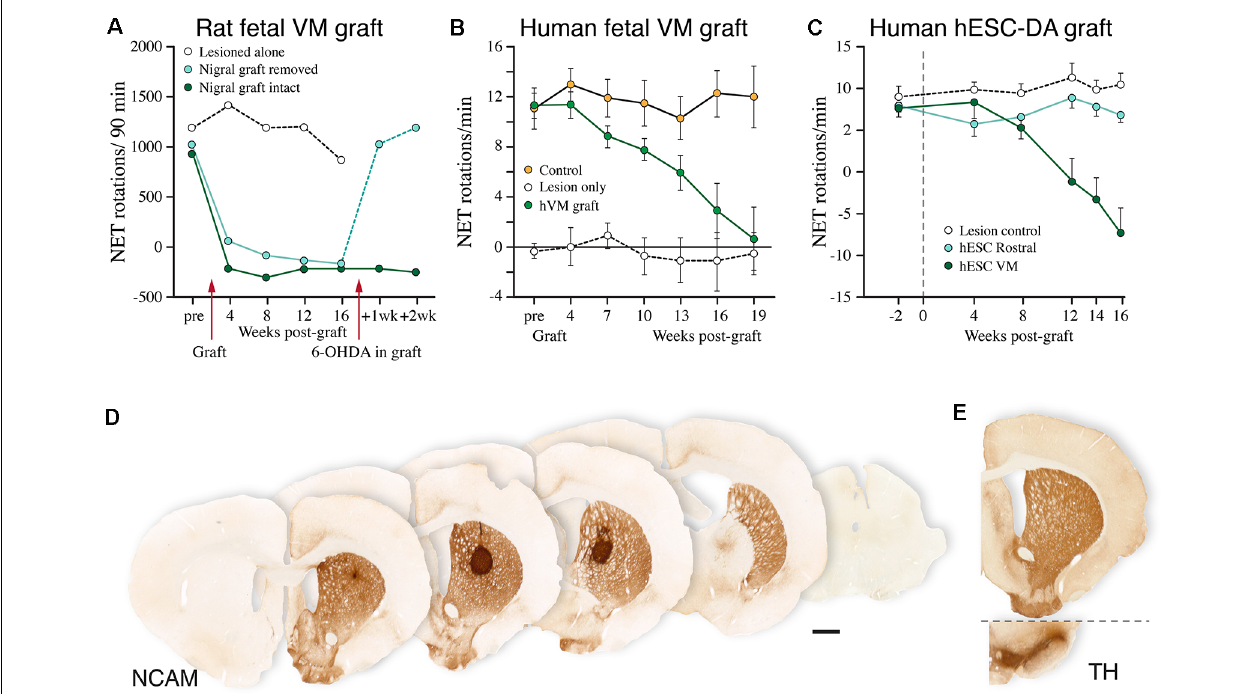
FIGURE 7 | Performance of human fetal and human embryonic stem cell (hESC)-derived DA neurons grafted to the striatum in the rat 6-OHDA lesion model. (A–C) Time-course of functional recovery in the amphetamine rotation test obtained with fetal rat VM transplants (A) , human fetal VM transplants (B) , and hESC-derived DA neuron transplants (C) . The time-course of recovery is notably similar for the fetal and hESC-derived human DA neurons, but much slower than that seen with rat DA neurons. In the experiment shown in panel (A) , the original functional deficit returned within a week after the graft had been removed with a second 6-OHDA lesion. (D) A single deposit of hESC-derived DA neurons is sufficient to reinnervate the entire striatum in the rat PD model, as visualized using a human-specific NCAM antibody. The graft-derived innervation pattern in (D) is notably similar to the distribution of the endogenous TH-positive innervation, as shown in ( E ; adapted from Nolbrant et al., 2017). Data compiled from Dunnett et al. (1988; A ), Lelos et al. (2016; B ), and Kirkeby et al. (2012; C ).